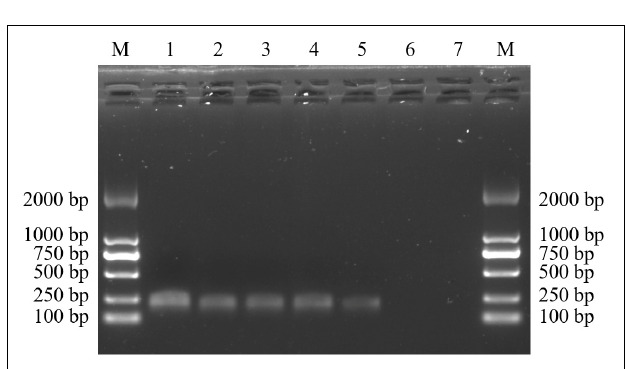
FIGURE 6 | Amplification profiles of the primer pair SHF/SHR in different genome DNA composition of Dendrobium species. Lane M: Trans2K DNA Marker with lengths (bp); Lane 1–7: different proportions of Dendrobium species adulteration provided in Table 5